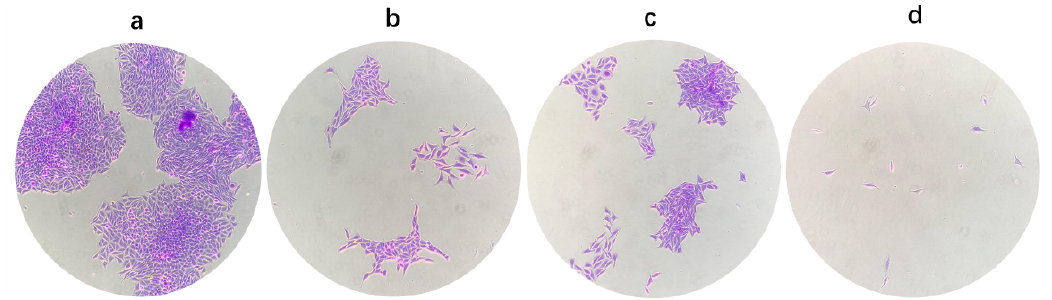
Figure 3. SGC-7901 cell colonies (control, a ) treated with 4.0 µM 1 ( b ), 15.0 µM 2 ( c ), and 15.0 µM 3 ( d ) for 8 days.